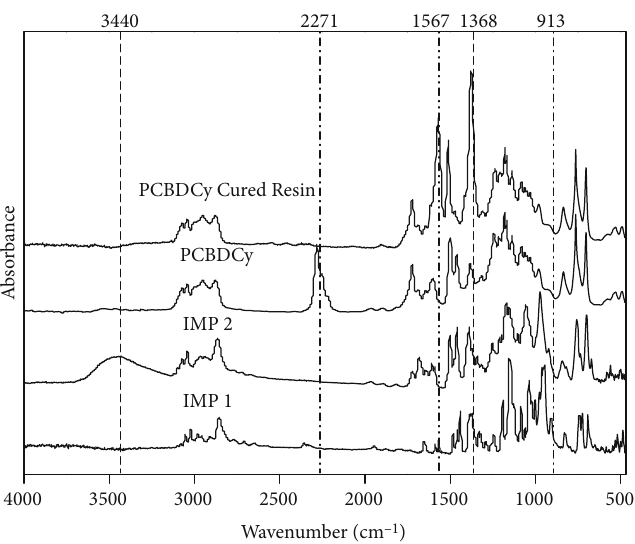
Figure 2: FT-IR spectra of IMP1, IMP2, PCBDCy, and the cured resin.